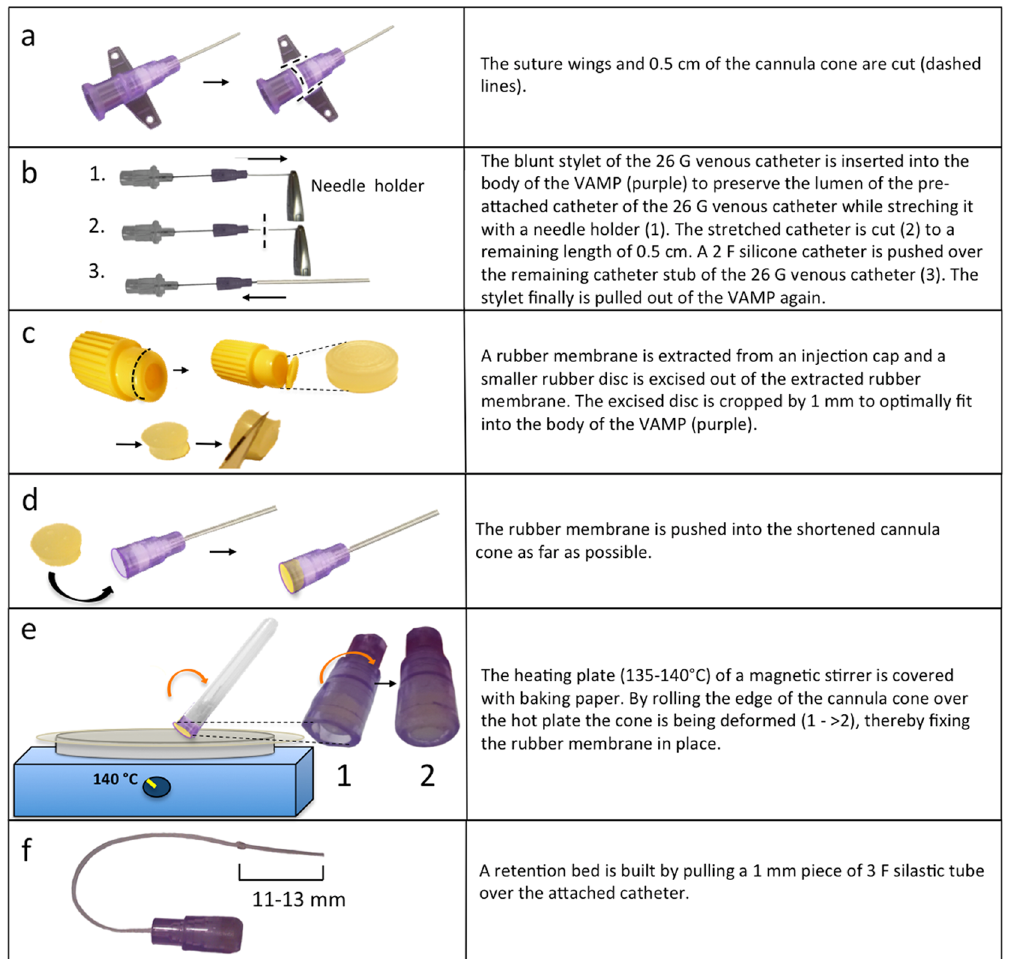
Figure 1. Schematic description on how to manufacture a low-cost metal-free vascular access mini-port (VAMP) for mice.